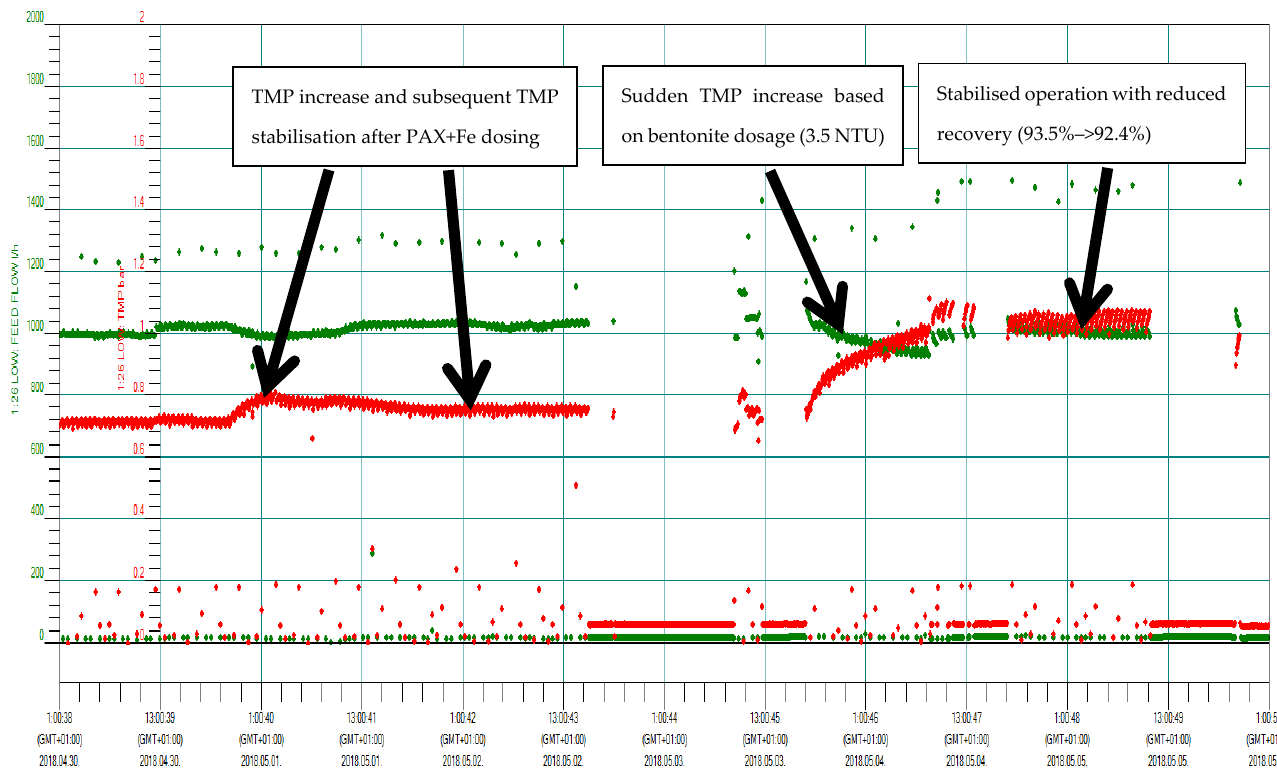
Figure A9. Flow and TMP with bentonite dosing.